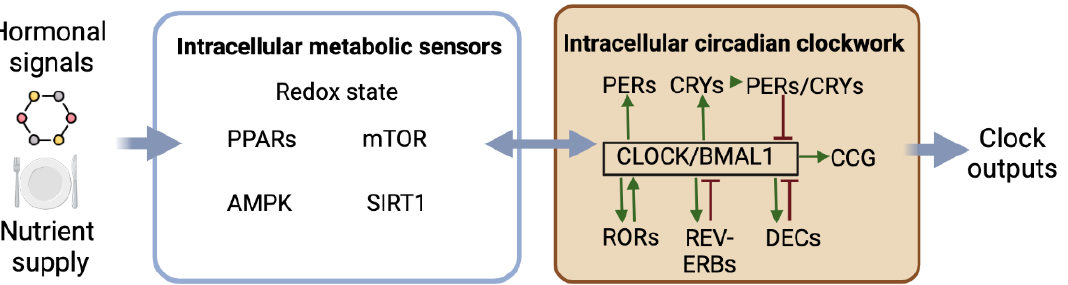
Figure 1. Schematic view of the intracellular machinery of circadian clocks and their interactions with cellular metabolic factors. Nutrient supply, hormonal signals, and physical activity directly influence intracellular metabolic sensors. These factors interact with different genes and proteins of the circadian clock mechanism reciprocally. The clock machinery is composed of different autoregulatory loops of activation and inhibition, providing feedback cues and clock outputs. AMPK, AMP-activated protein kinase; BMAL, brain and muscle aryl-hydrocarbon receptor nuclear translocator-like protein; CCG, clock-controlled genes; CLOCK, circadian locomotor output cycles kaput; CRY, cryptochrome; DEC, differentially expressed in chondrocytes protein; mTOR, mammalian/mechanistic target of rapamycin; PER, period; PPAR, peroxisome proliferator-activated receptor; REV-ERB, reverse viral erythroblastosis oncogene product; ROR, retinoic acid receptor-related orphan receptor; SIRT, sirtuin. Created with https://www.biorender.com/ (accessed on 10 February 2023) .